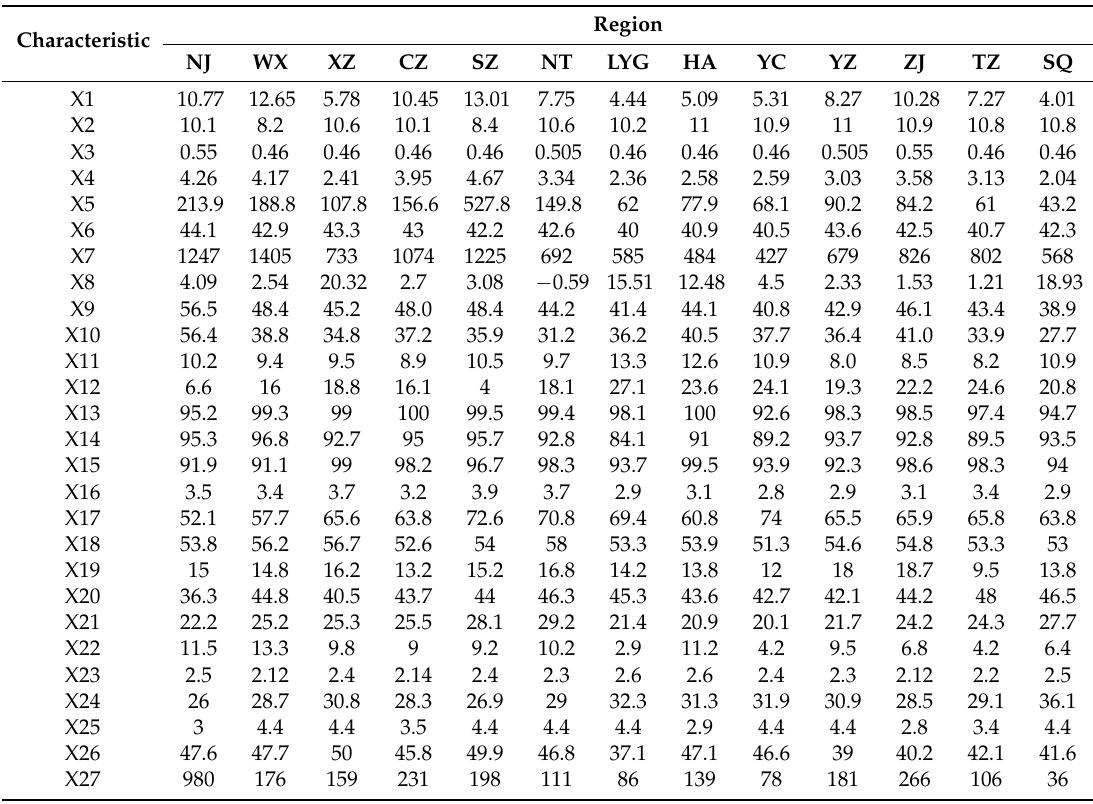
Figure 1. Location of the study area. Table 1. Characteristics of each city in Jiangsu Province in 2014.